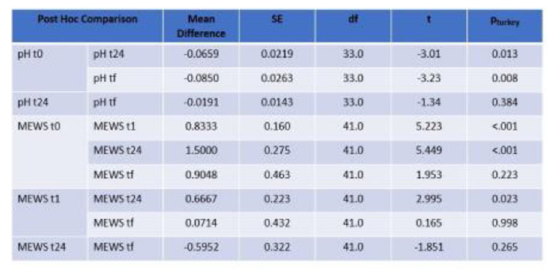
Table 3 (abstract A195). See text for description